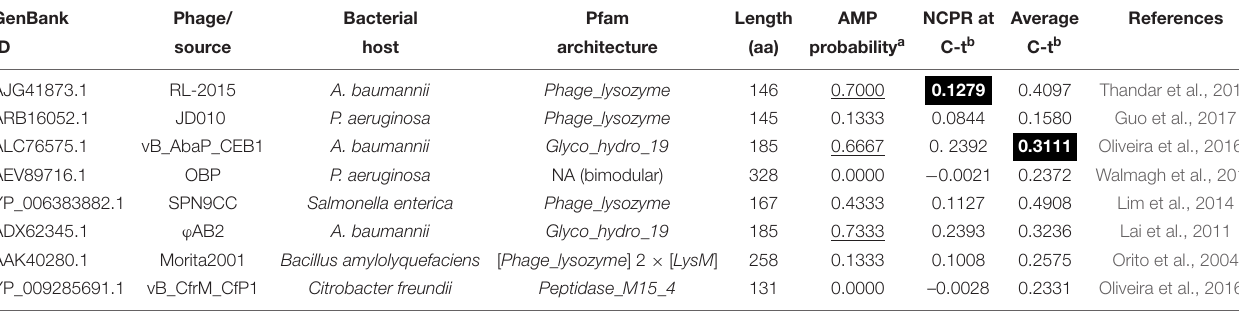
TABLE 1 | Previously reported examples of lysins active from without against G-